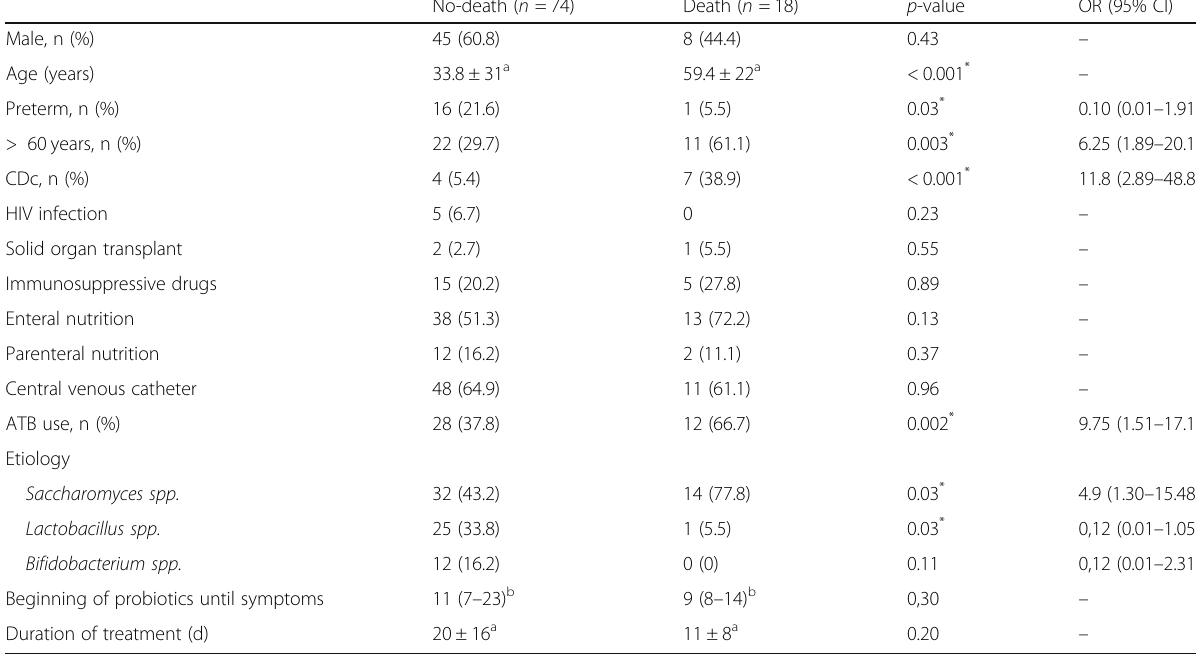
Table 3 Univariate analysis of clinical and microbiological predictors of death in 93 cases of infectious complications after probiotic use, identified by systematic review, 1976 –